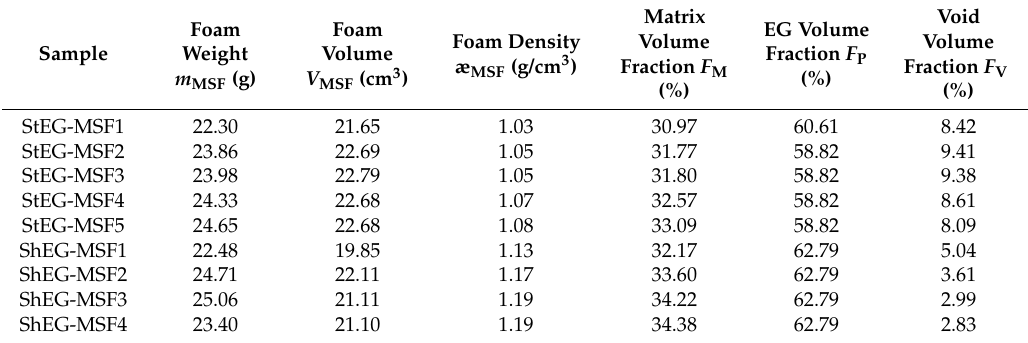
Table 2. Physical properties of EG-MSF samples (St and Sh mean stable and shrunk EG, respectively).